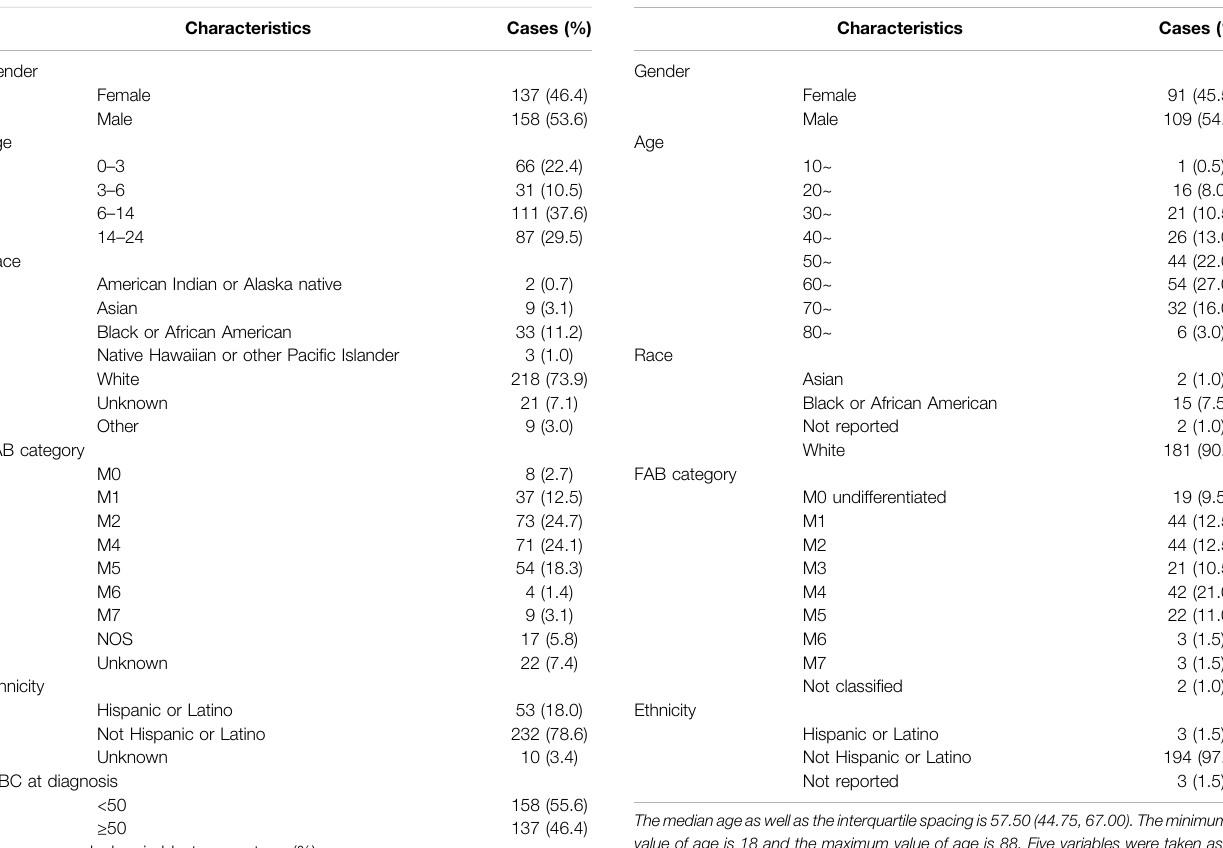
TABLE 1 | Baseline characteristics for 295 patients with AML in the TARGET database ( n = 295). Characteristics